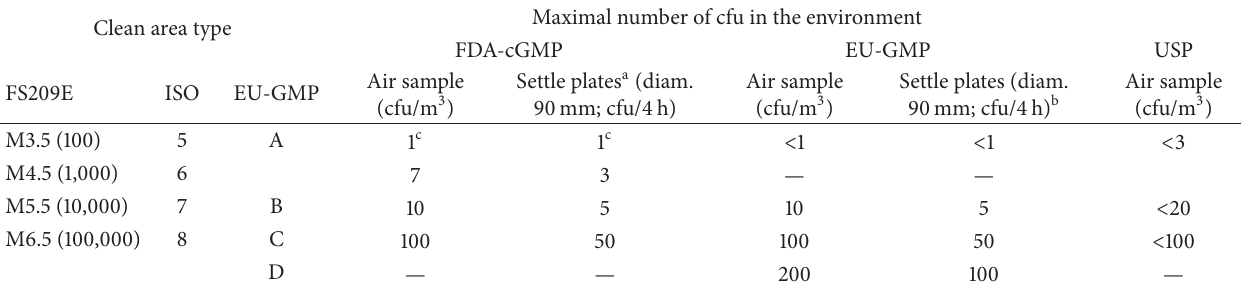
Table 6: Recommended limits for viable airborne particles in the environment according to FDA-cGMP, EU-GMP, and USP. Clean area